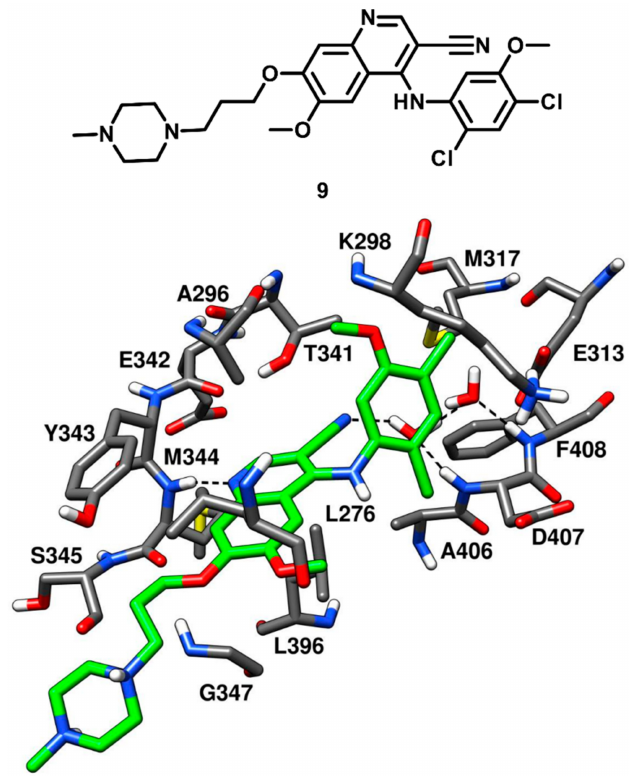
Figure 10. 2D structure of 9 and X-ray structure of c-Src kinase in complex with 9 (PDB ID: 4MXO). Active site residues of c-Src kinase and the enzyme–inhibitor H-bond interactions are